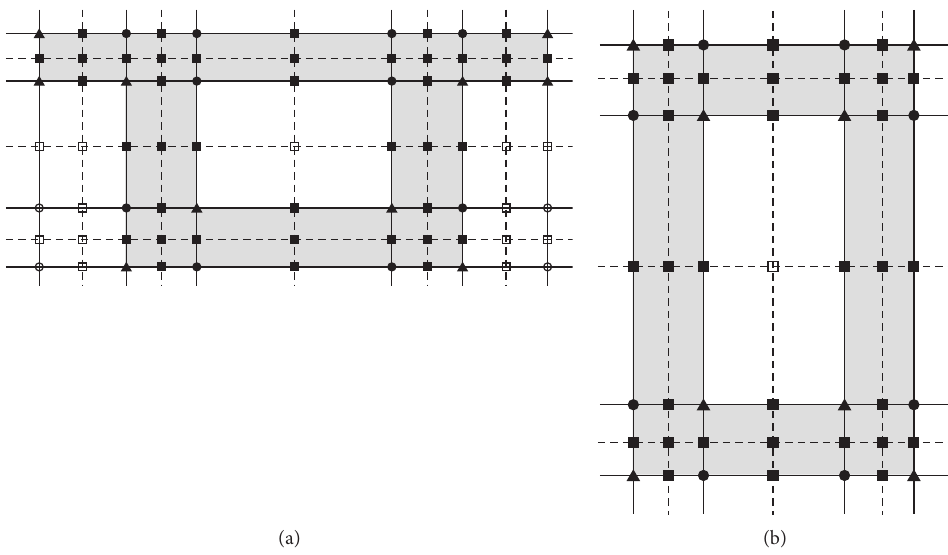
Figure 2: Key points’ selection of bridge pier and beam section. (a) Box girder. (b) Hollow